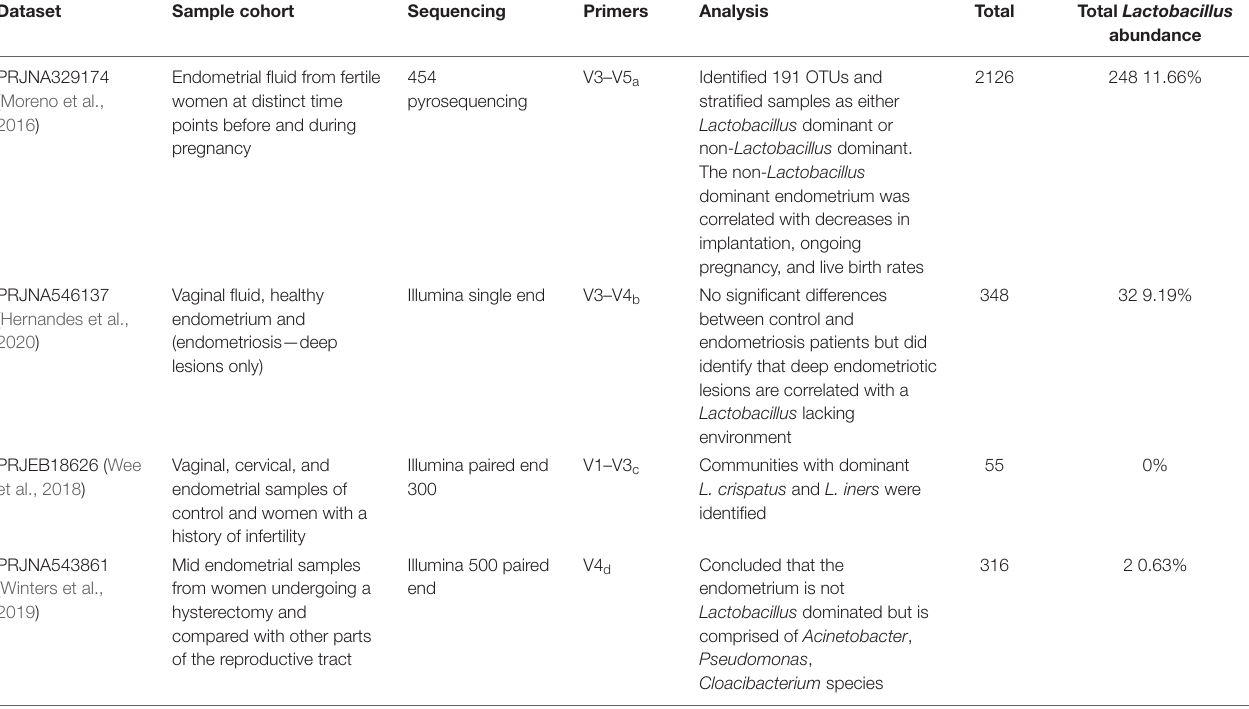
TABLE 3 | Comparison of publicly available 16S rRNA endometrial datasets used for the sequencing re-analysis.